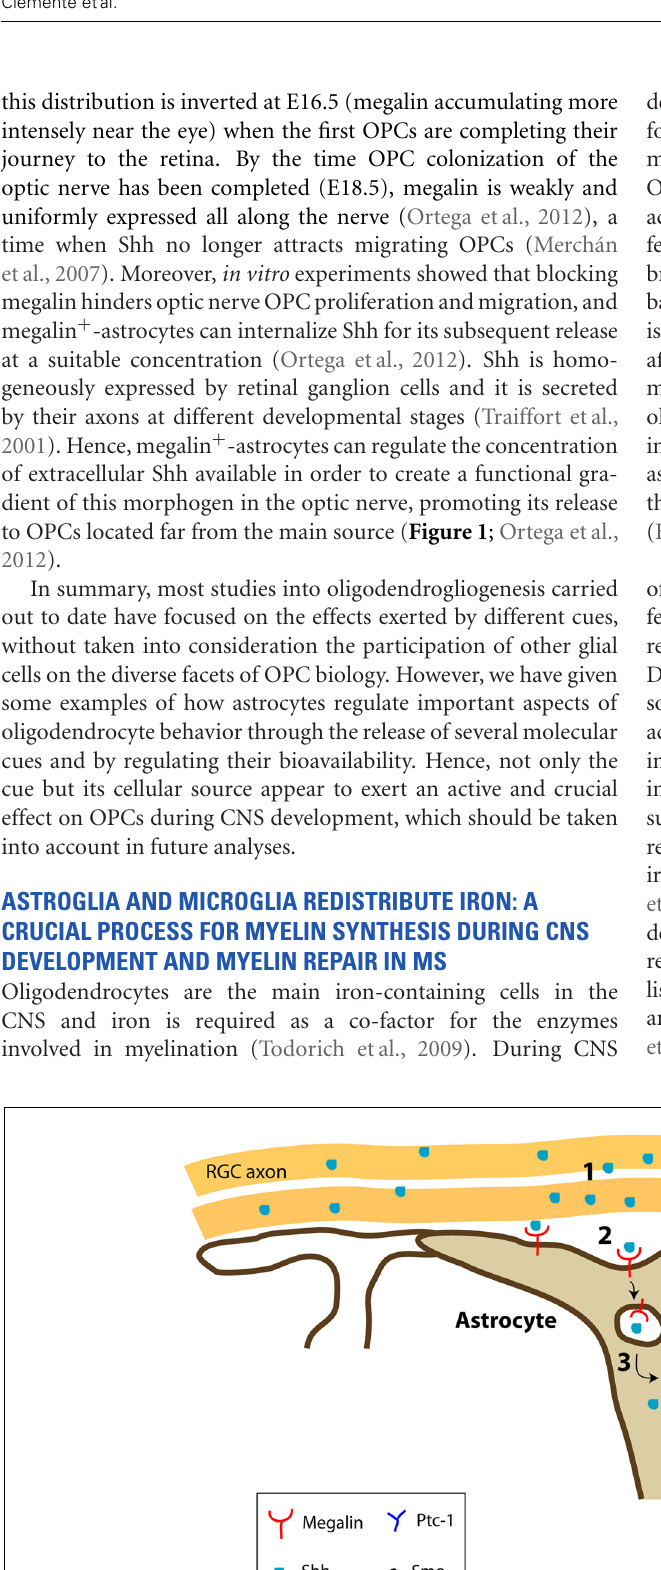
transcytosed across the astrocytes to be released. (4) Once released, Shh exerts its effects on Ptc-1 + -expressing OPCs in the optic nerve, promoting their migration and proliferation. RGC, retinal ganglion